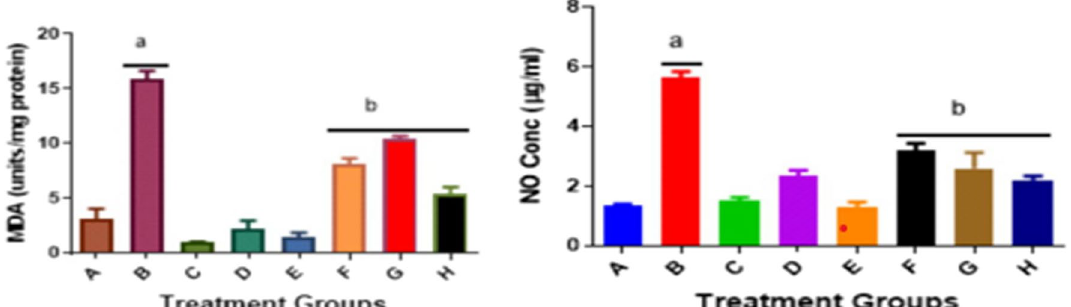
Fig. 2 AEAC and quercetin ameliorated KBrO3 mediated inflammatory biomarkers (Malondialdehyde and Nitric oxide) in male Wistar rats. Values are mean SD (n 5), a significantly different compared with the negative control group A (p < 0.050). b significantly different compared with ± = = = the positive control group B treated with KBrO3 only (p < 0.05). Group A received distilled water, B: 30 mg/kg KBrO3, C: 50 mg/kg Quercetin, D: 300 mg/kg AEAC, E: 150 mg/kg AEAC, F: KBrO3 300 mg/kg AEAC, G: KBrO3 150 mg/kg AEAC, H: KBrO3 Quercetin + + +